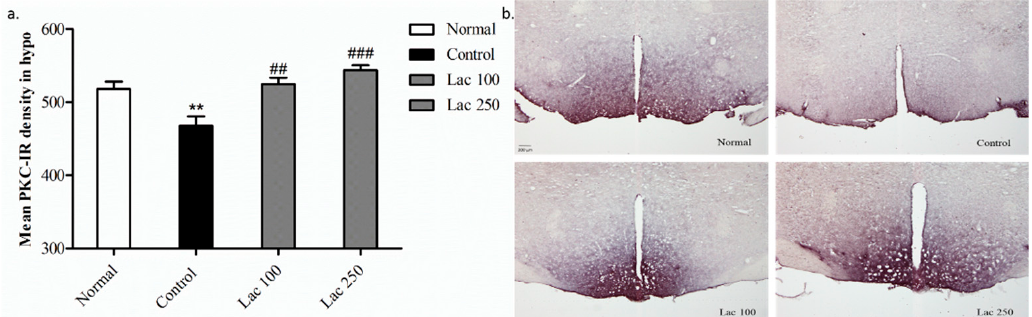
Figure 9. Oral lactate administration regulated protein kinase C (PKC) expression in the hypothalamic area. ( a ) Both the lactate 100 and 250 groups significantly upregulated the mean PKC-IR cell density in the hypothalamus ( n = 6). ( b ) Representative images of all groups for PKC+ cell expression in hypothalamic region. PKC density was markedly increased in both lactate groups compared to the control group (the scale bar represents 200 µm). Values are presented as mean ± SEM. ** show differences between the normal and control groups, while ## and ### show significant differences between the control group and treatment groups. ## p < 0.01 and ### p < 0.001. The p -value of the test was <0.001 by one-way ANOVA, followed by a post hoc LSD test.